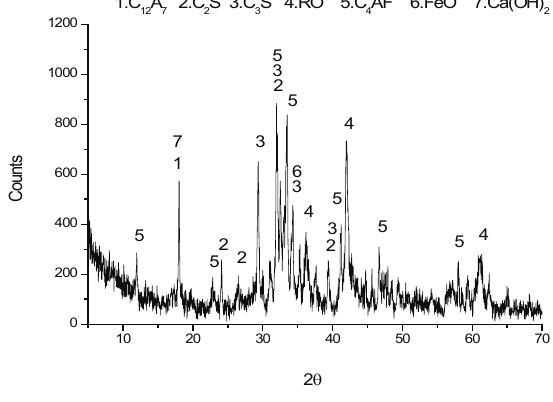
Figure 4: XRD analysis of steel slag powder.